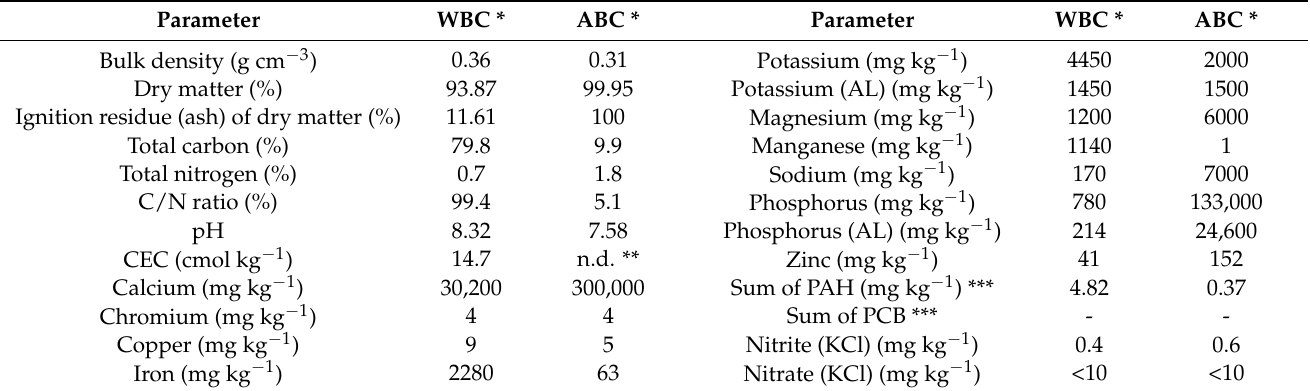
Table 1. Characteristics of the two applied biochars.